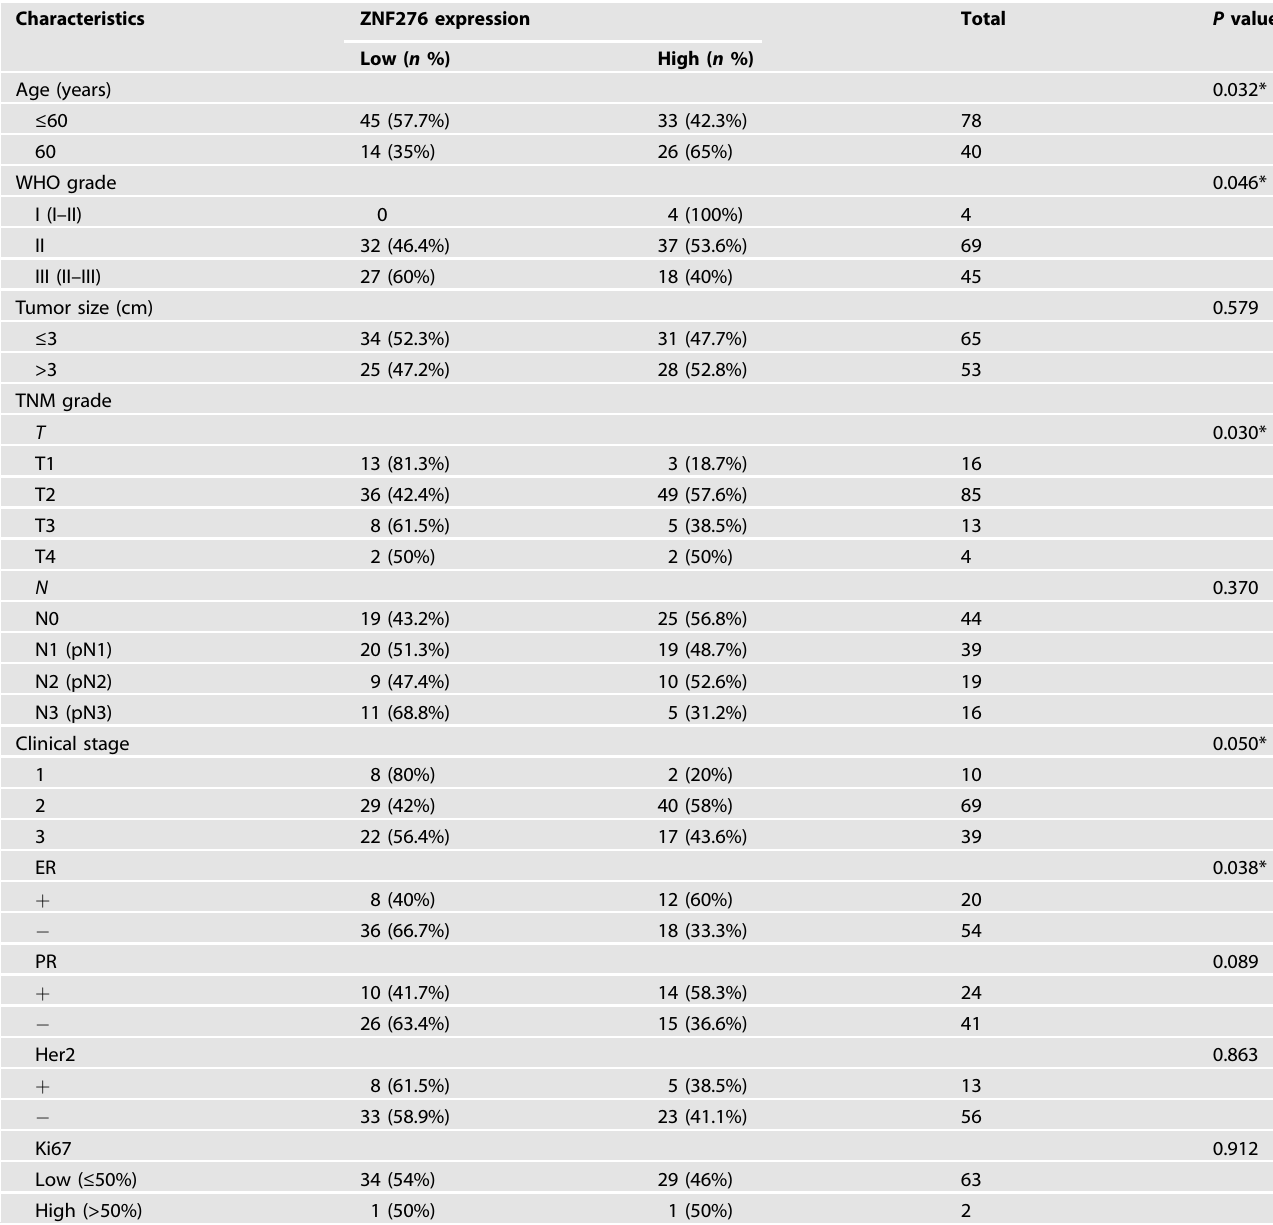
Table 1. Association between ZNF276 expression and clinicopathologic features of patients with breast cancer ( n = 118).